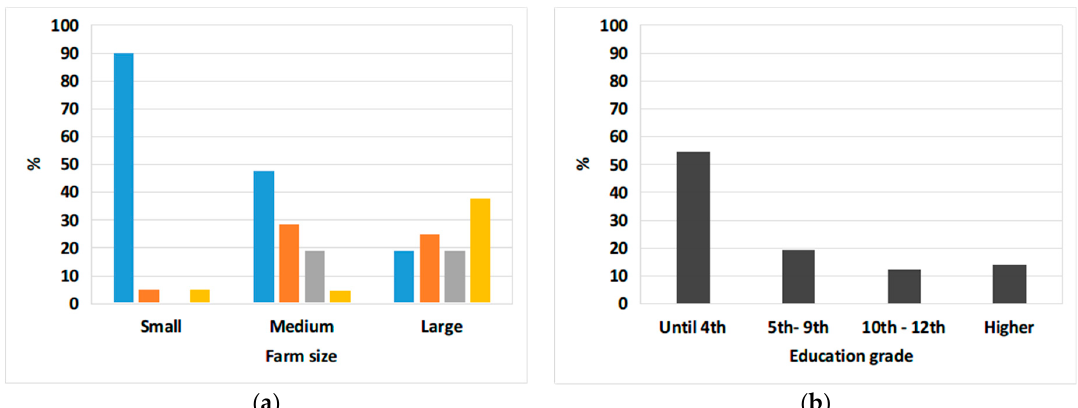
Figure 3. Relative frequency (%) of educational level of respondents by: ( a ) the farm size (Until the 4th grade, blue; 5–9th grade, orange; 10–12th grade, grey; Higher education, yellow), and ( b ) the overall responses. Farm size: Small (lower than 25 m 2 ), Medium, Large (over 8.5 ha).